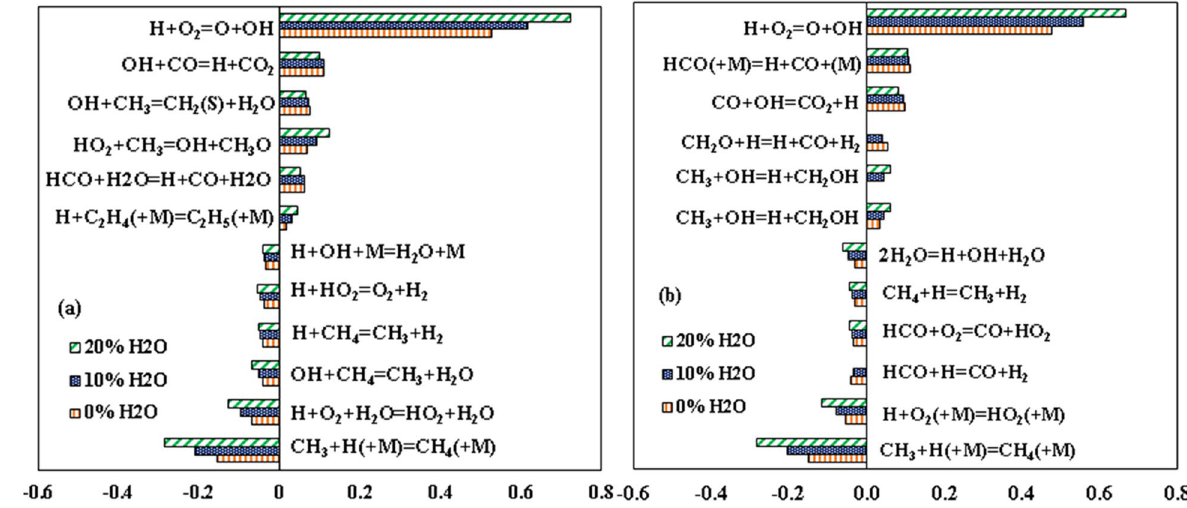
Figure 12. Normalized sensitivity coefficient for the flow rate using ( a ) GRI-3.0 and ( b ) Glarborg mechanism for 0%, 10% and 20% dilution 34 .